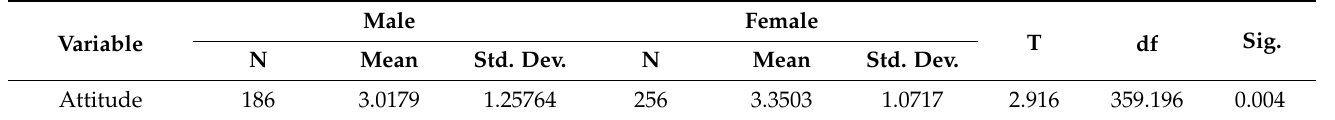
Table 7. t -test of the respondent Attitude attributed to gender.